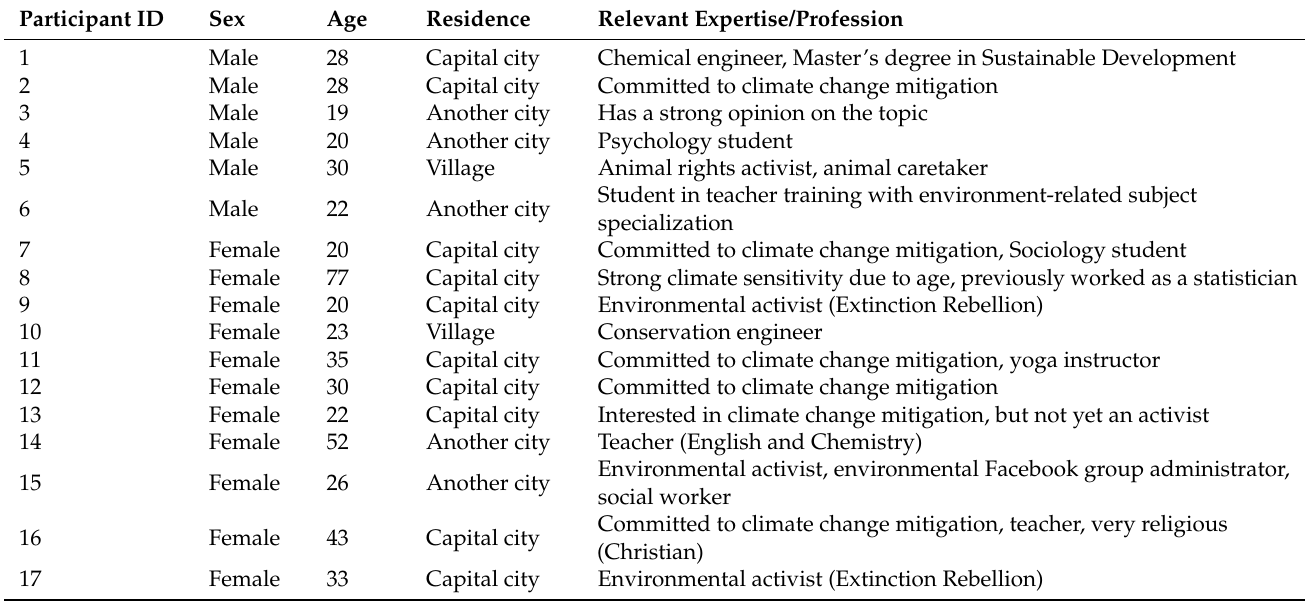
Table 1. The main characteristics of the